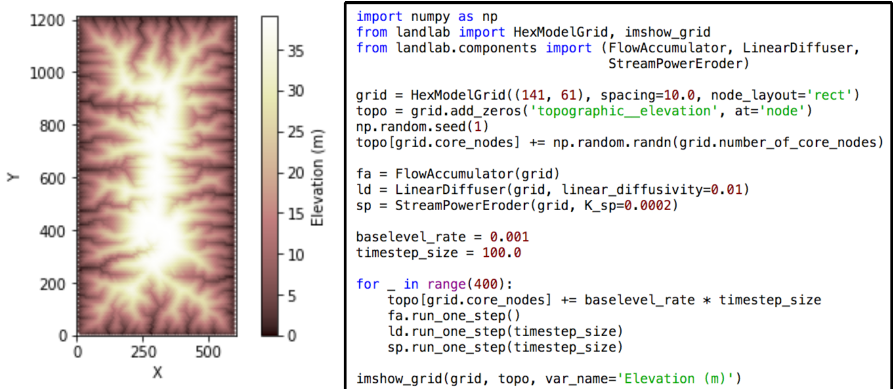
Figure 11. Example of a simple landscape evolution model written using the Landlab programming library. Model code at right illustrates the use of three components to create the